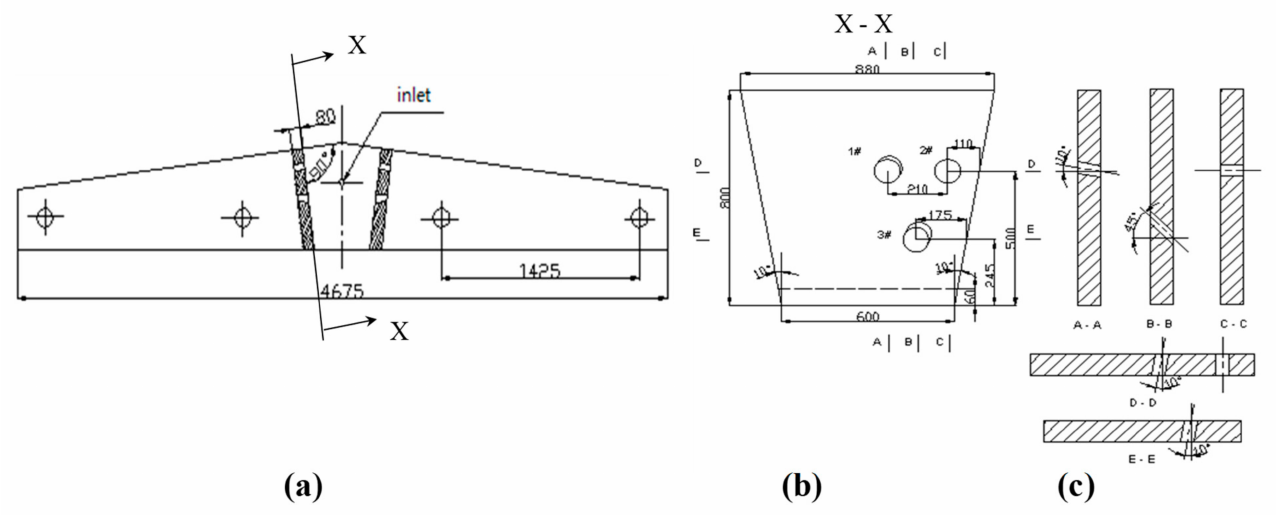
Figure 2. ( a ) A schematic diagram of the tundish (top view of 1 in Figure 1); ( b ) cross-sectional (X-X) view of the baffle used in the tundish; ( c ) cross-sectional views of holes in the